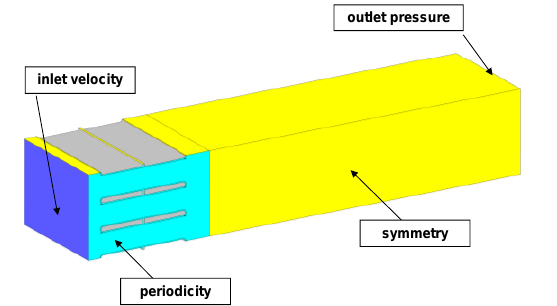
Fig. 3. The overall model with boundary conditions.